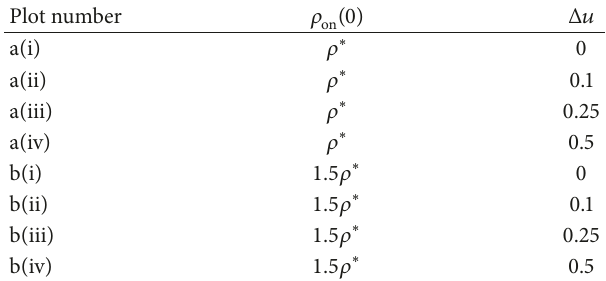
Table 3: Parameter values for plots in Figures 8, 9, and